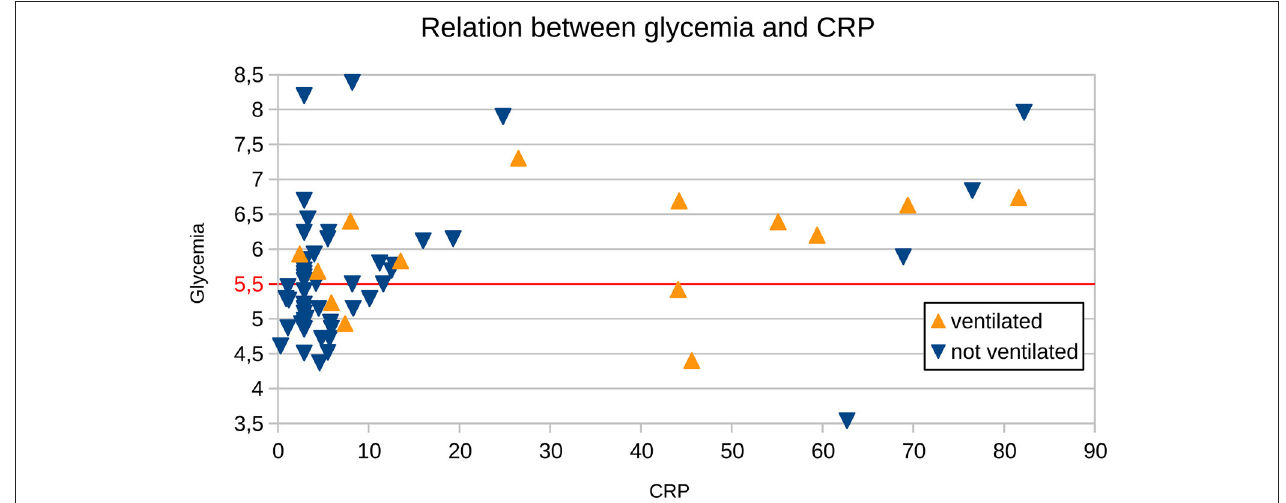
FIGURE 1 | Relation between CRP and glycemia in subjects who did not require ventilation support (“not ventilated”) and those who did (“ventilated”). The red horizontal line represents a cut-off value for normal glycemia